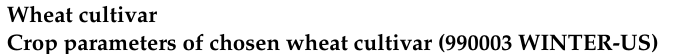
Table 3. Calibrated crop parameters for wheat and corn